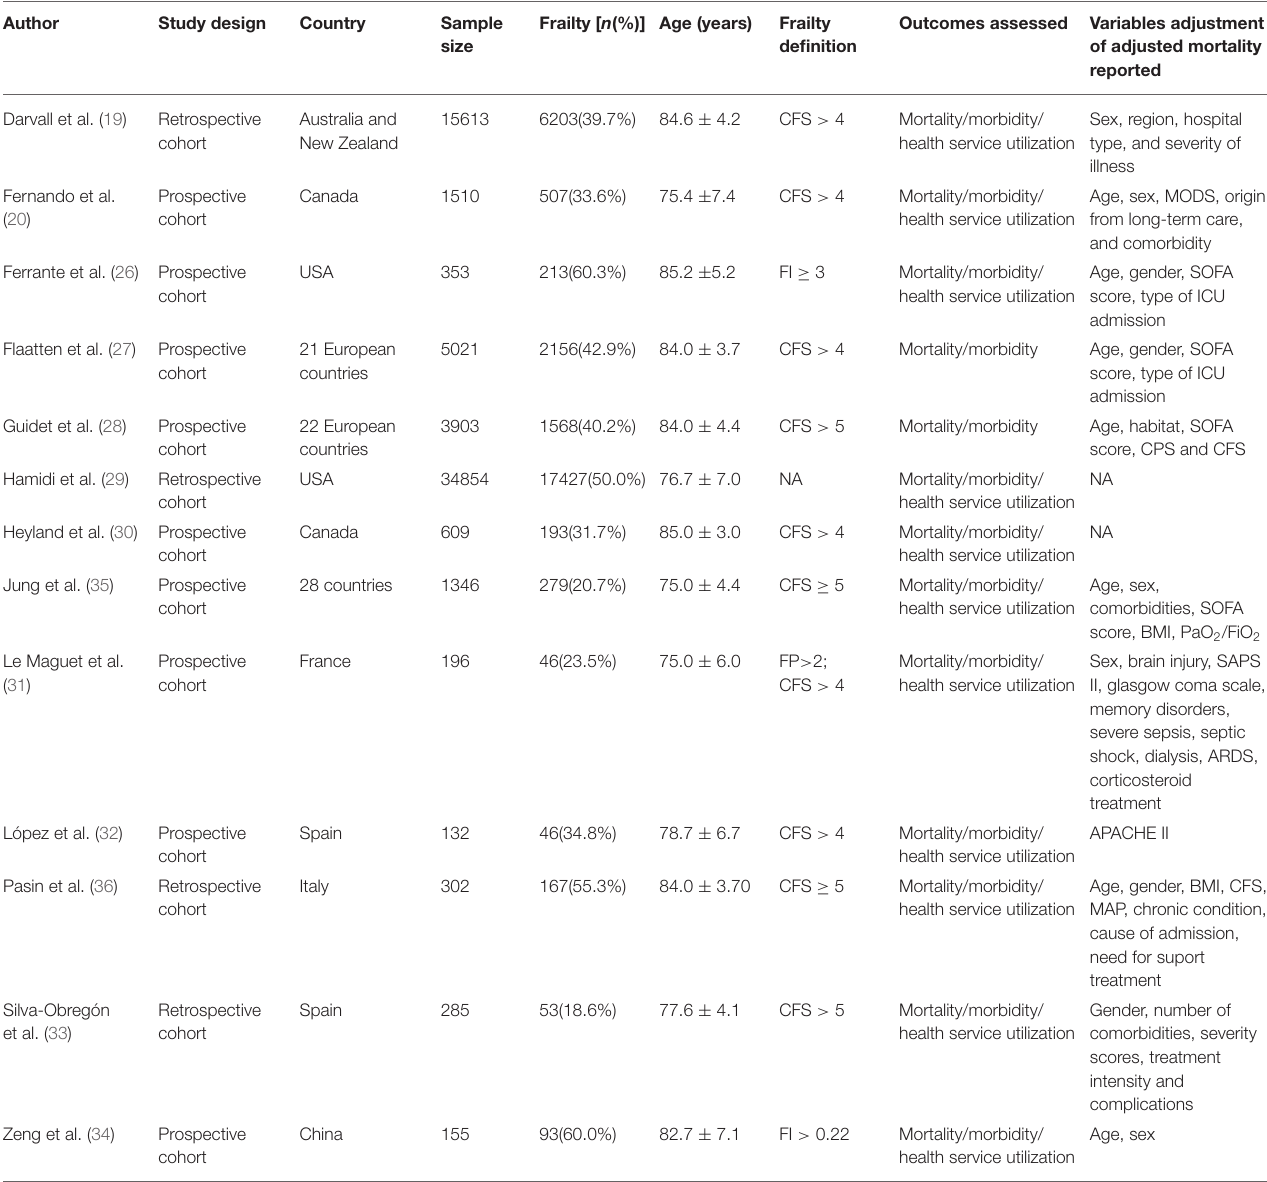
TABLE 1 | Characteristics of included studies.